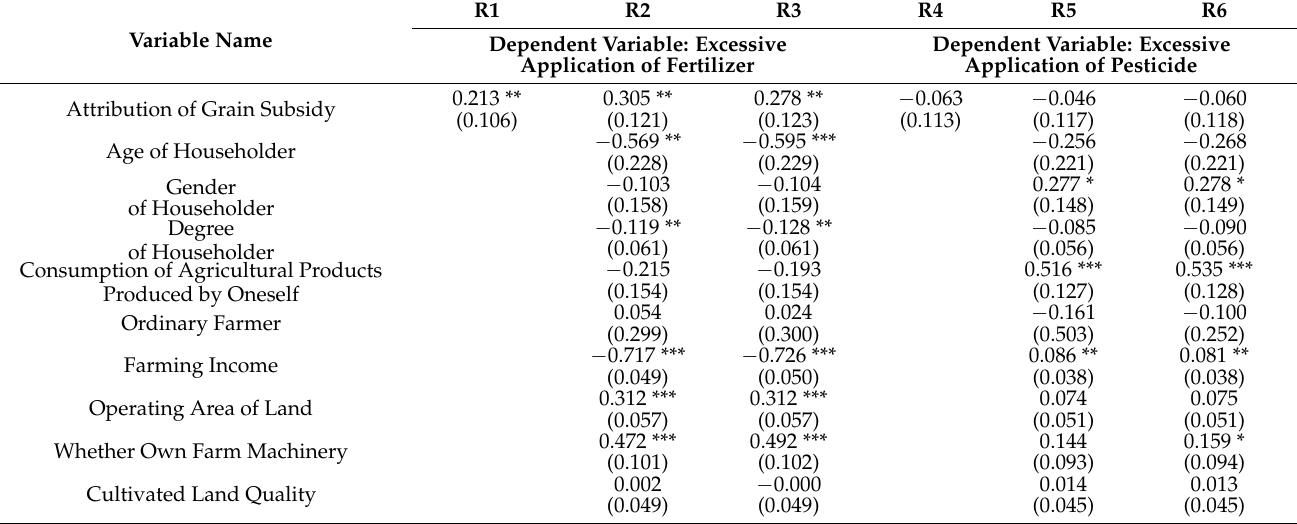
Table 6. Results of the impact of the grain subsidy policy on farmers’ green production